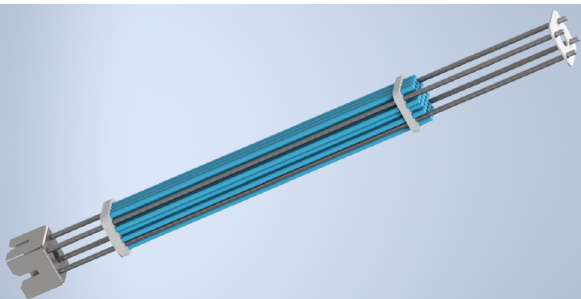
Figure 2: Design of VR-1 stainless steel